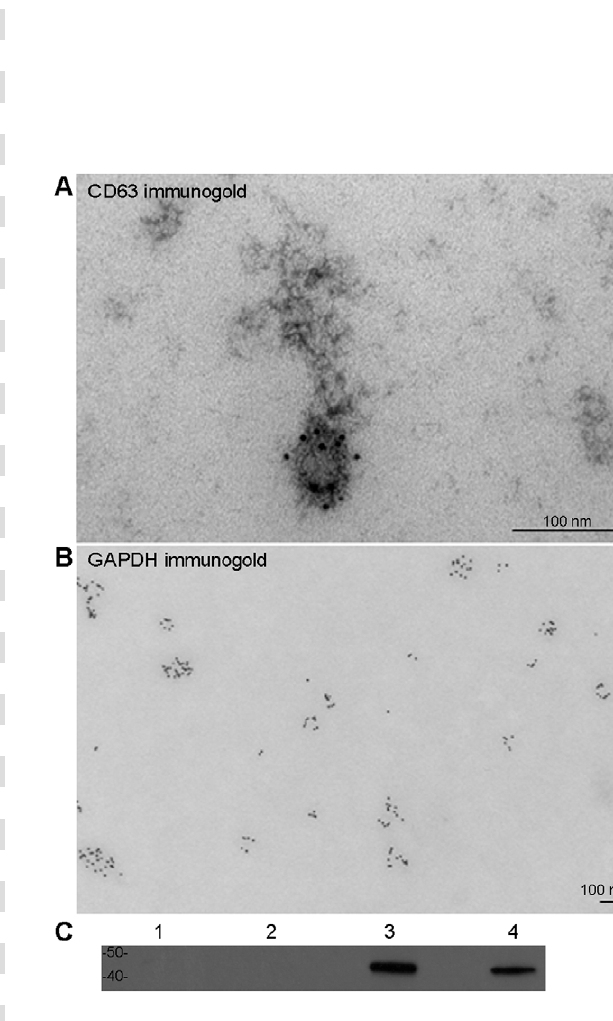
Figure 1. Characterization of exosome-containing pellets from human brain tissue. Electron microscopy of exosomal extractions from BA9 cortices demonstrates the presence of microvesicles ( , 70– 100 nm in diameter). Upon immuno-gold labeling procedure with antibodies against CD63 (A; additional negative staining highlights membrane of the vesicle) and GAPDH (B), the microvesicles reveal the presence of exosome-associated antigens. Bars indicate 100 nm. Comparison of exosomal extraction procedure products from BA9 cortices and H4 cell-culture reveals similar outcomes in Western blot. Supernatant of BA9 exosome-containing pellets (lane 1), supernatant of H4 exosome-containing pellets (lane 2), BA9 exosome-containing pellets reconstituted in PBS (lane 3), and of H4 exosome-containing pellets reconstituted in PBS (lane 4), show robust presence of exosomal marker flotillin-2 in the pellets, but not in the supernatants